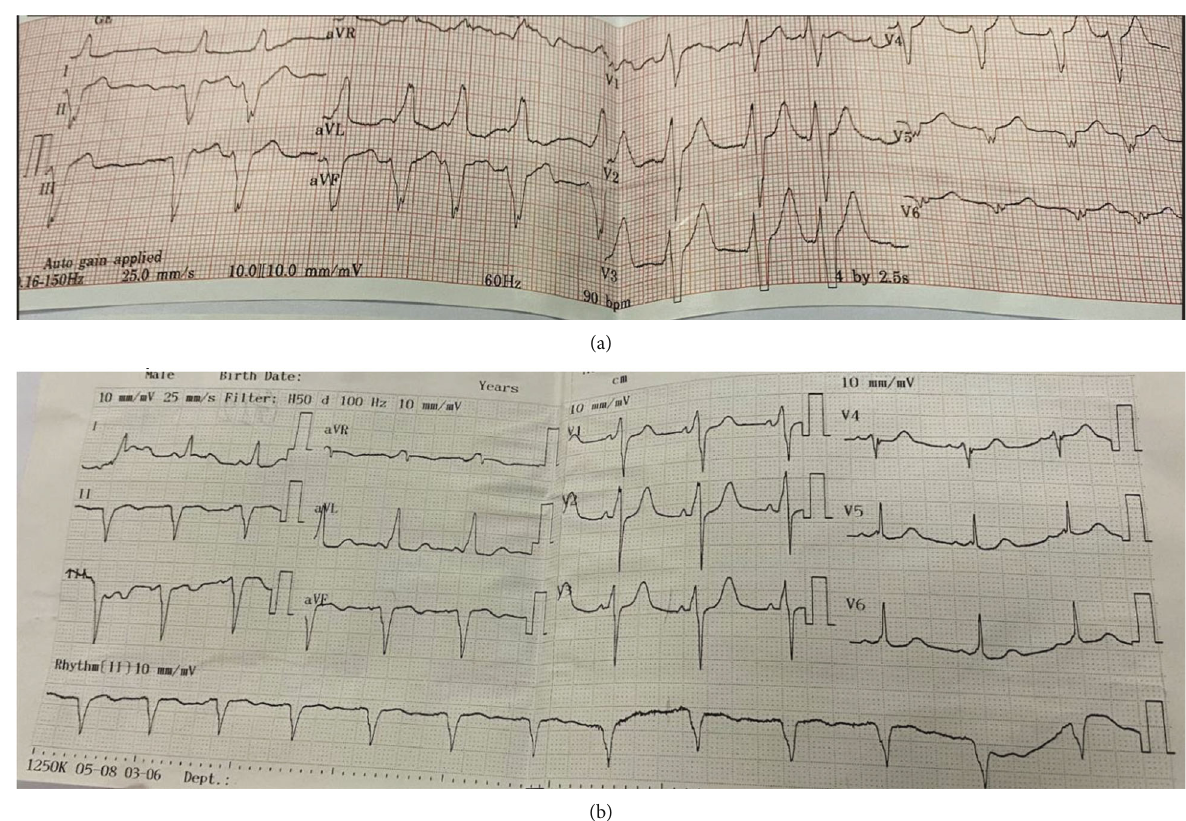
Figure 1: (a) ECG shows irregularly wide QRS tachycardia with ventricular rate ranging from 130 to 150bpm and delta wave. (b) ECG shows a sinus rhythm heart rate of 70 bpm, delta waves, wider QRS, and short PR suggesting WPW syndrome with the right side accessory pathway.